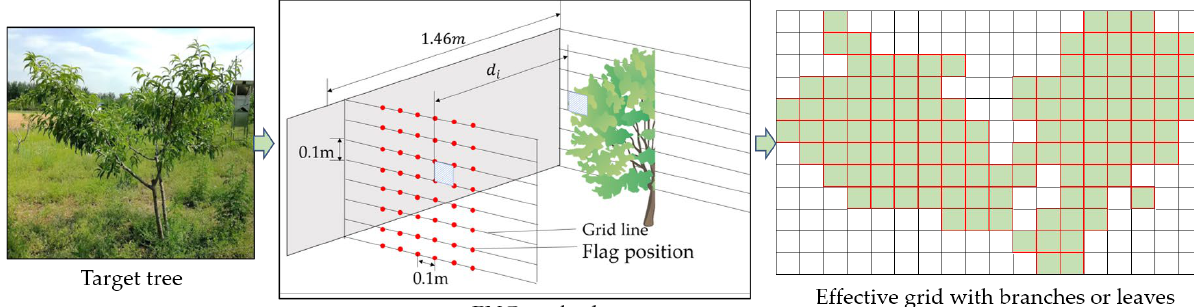
Figure 2. Principle of artificial canopy volume measurement.